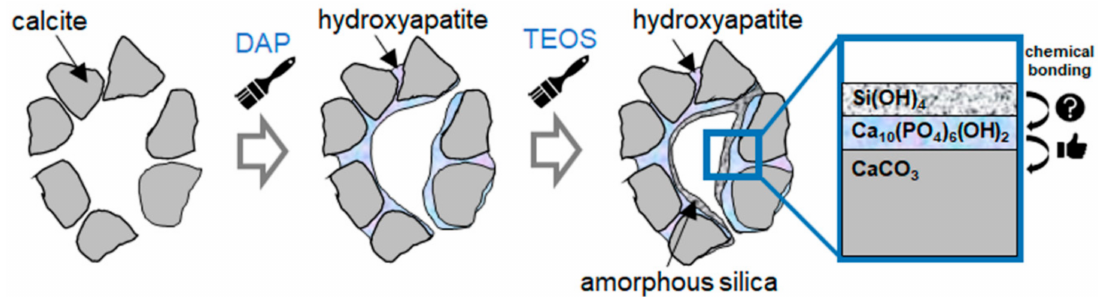
Figure 8. Scheme illustrating the possible use of HAP as a coupling agent for silicate consolidants applied to limestones. However, the bonding between the silicate consolidant and the HAP layer was found to be mechanical in